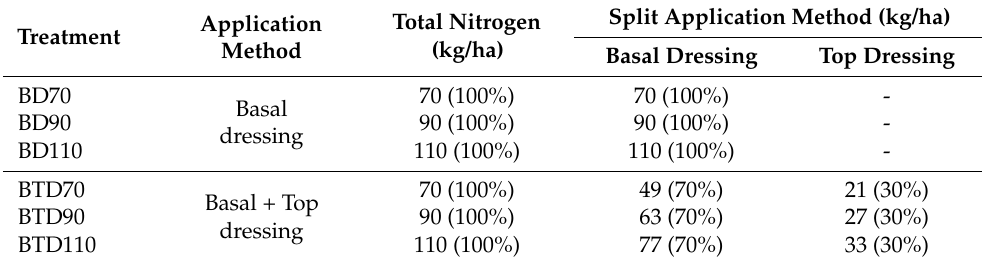
Table 2. Summary of treatments for nitrogen application